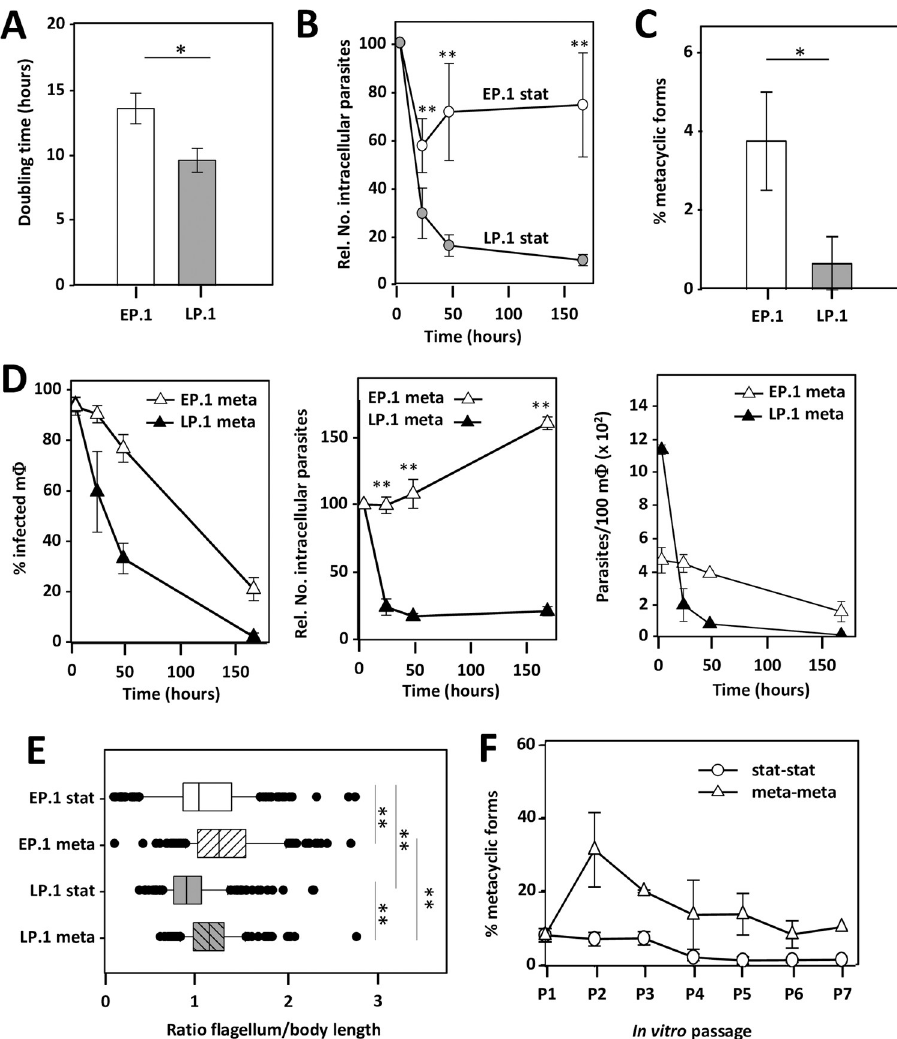
Fig 1. Phenotypic analysis of EP.1 and LP.1 parasites reveals fitness tradeoff between in vitro proliferation and macrophage infectivity. (A) Histogram plot representing the generation time of EP.1 and LP.1 promastigotes in culture calculated based on parasite density during logarithmic growth phase. The mean value of three independent experiments +/- SD is represented. � p-value � 0.05. (B) Macrophage infection assay. The mean relative number of intracellular EP.1 (open circles) and LP.1 (grey circles) parasites +/- SD of three independent triplicate experiments using promastigotes from day-3 stationary culture is represented. �� p-value � 0.01. (C) Histogram plot representing the percentage of EP.1 and LP.1 metacyclic forms that were enriched by Ficoll density gradient centrifugation from cultures at stationary growth phase. Each bar represents the mean +/- SD of four independent experiments. � p- value � 0.05. (D) Macrophage infection assay using Ficoll-enriched metacyclic parasites. Percentage of infected macrophages (left panel), mean relative number of intracellular EP.1 and LP.1 parasites (middle panel) and mean number of parasites per 100 macrophages (right panel) are shown. Open triangles, EP.1 meta; close triangles, LP.1 meta. The mean values +/- SD of one triplicate experiment are shown. �� p-value � 0.01. (E) Morphological characterization of EP.1 and LP.1 Ficoll-enriched metacyclic parasites. Body width, flagellum and body length were measured on 200 promastigotes using the Image J software package. The ratio flagellum-to-body length was computed from two biological replicate experiments and the median values +/- SD are represented by the box plot with the upper and lower quartiles indicated. �� p-value � 0.01. (F) Percentage of metacyclic-like parasites recovered by Ficoll gradient centrifugation from cultures seeded successively for 6 in vitro passages with either EP.1 from stationary growth phase (stat-stat) or EP.1 metacyclic-enriched parasites (meta-meta). Mean values of two independent experiments are shown with +/-SD denoted by the